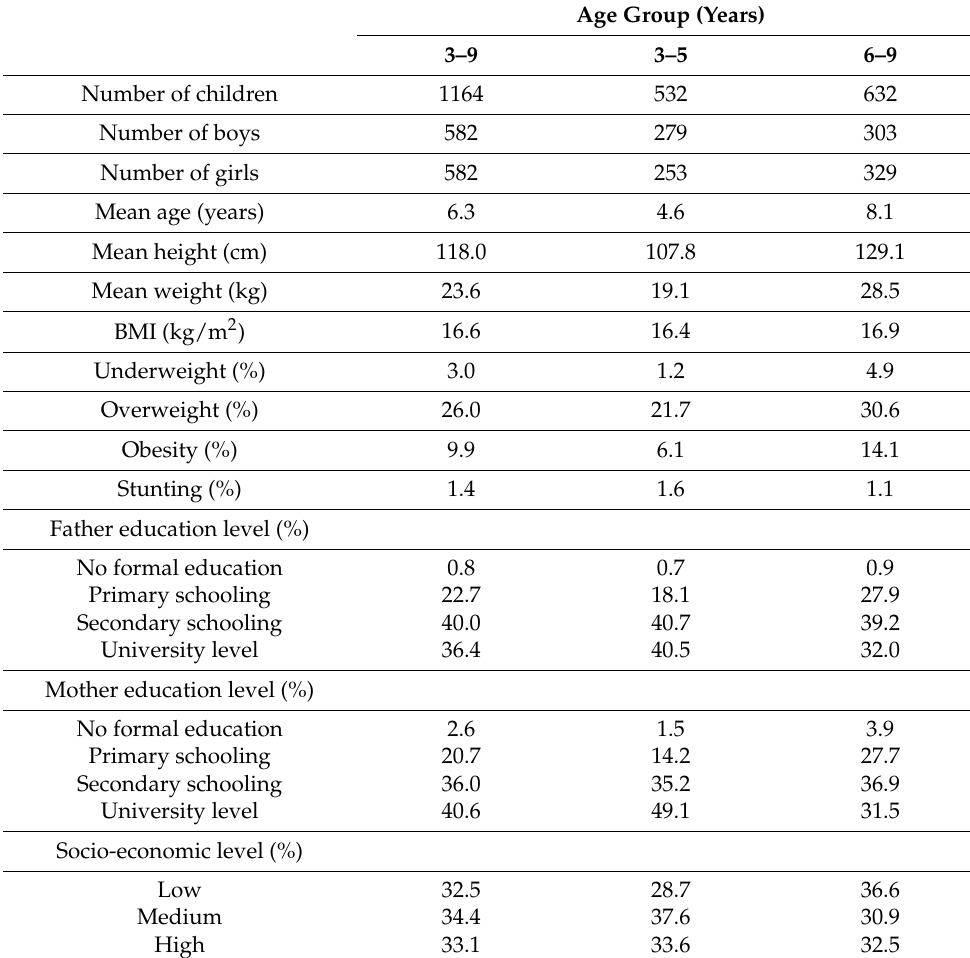
Table 1. Characteristics of Tunisian preschool and school